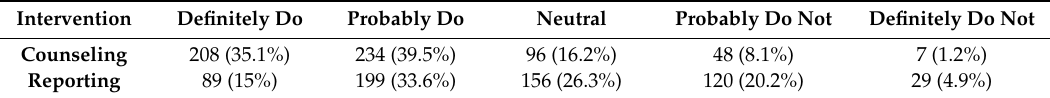
Table 4. Respondents’ intention toward being involved in suspected animal abuse